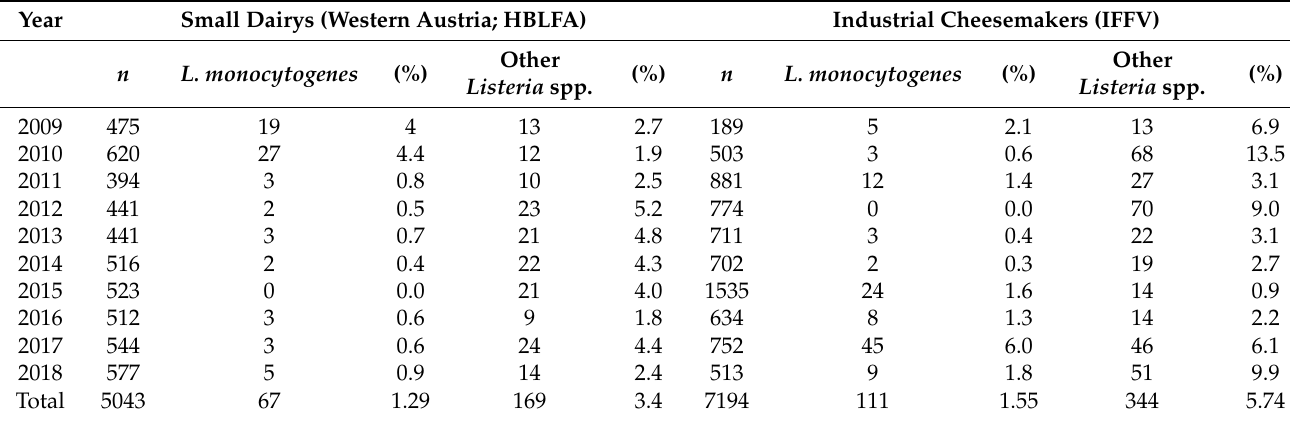
Abbreviations: Small dairys and industrial cheesemakers supervised by Higher Federal Teaching and Research Institute Tyrol (HBLFA) and Institute of Food Safety, Food Technology and Veterinary Public Health (IFFV); Listeria spp., Listeria species other than L. monocytogenes differentiated by iap PCR